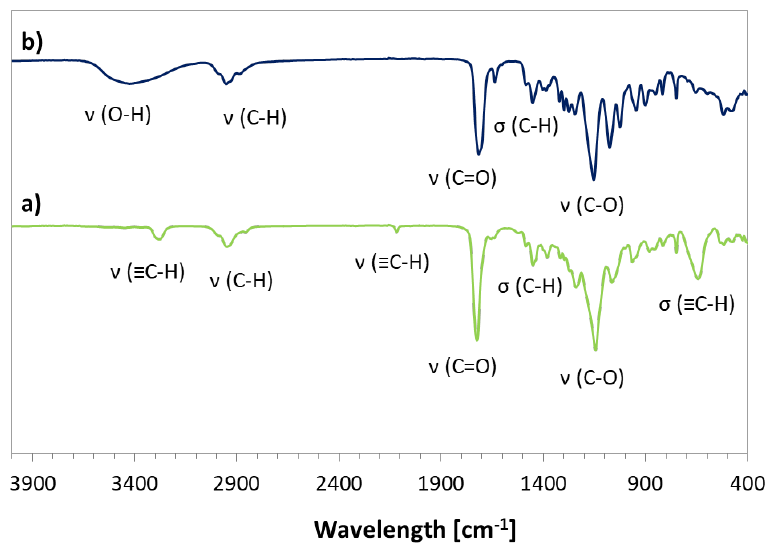
Table 1. Data for synthesis of AlHEMA/MMA copolymers by ATRP .